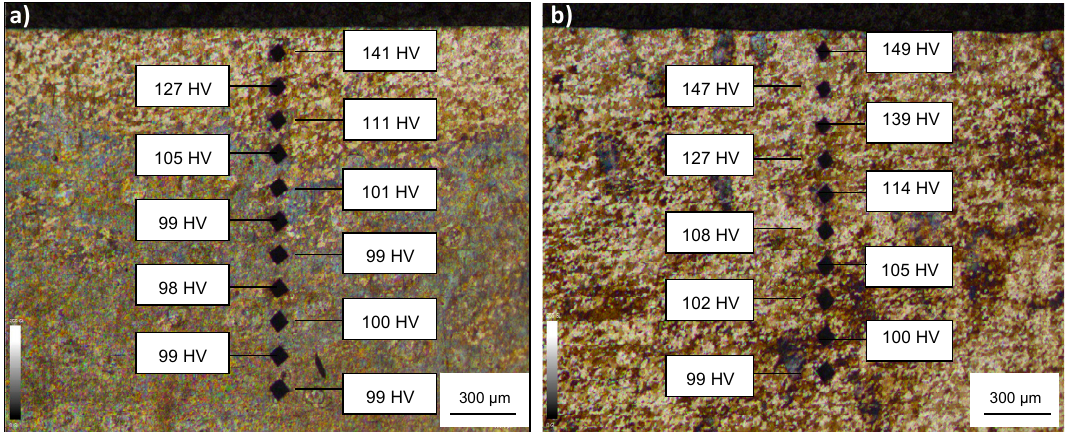
Figure 17. Microhardness values. ( a ) After burnishing operation (P = 10 MPa); ( b ) after burnishing operation (P = 30 MPa).